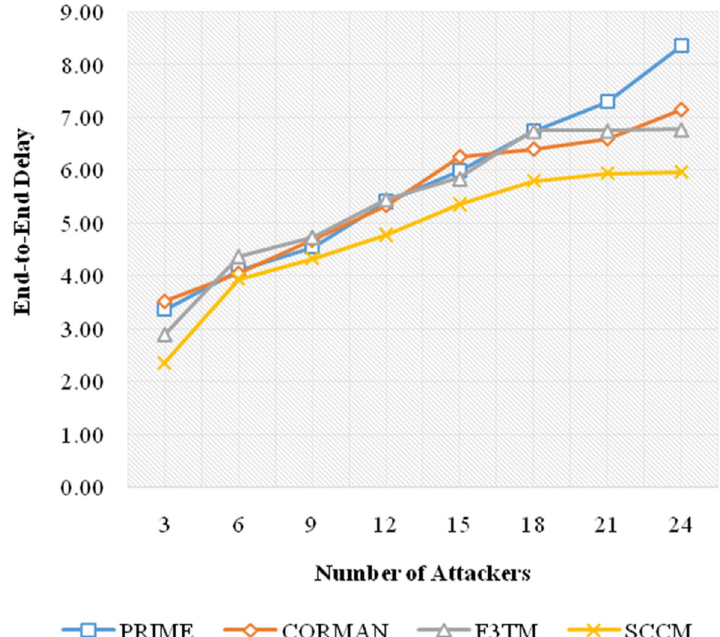
Fig. 10 Average end-to-end delay vs number of attackers